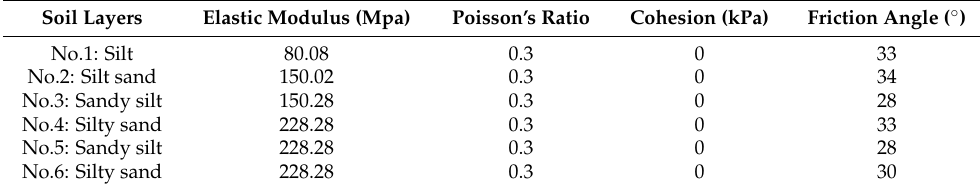
Table 1. The physical parameters of soil properties [25,27].